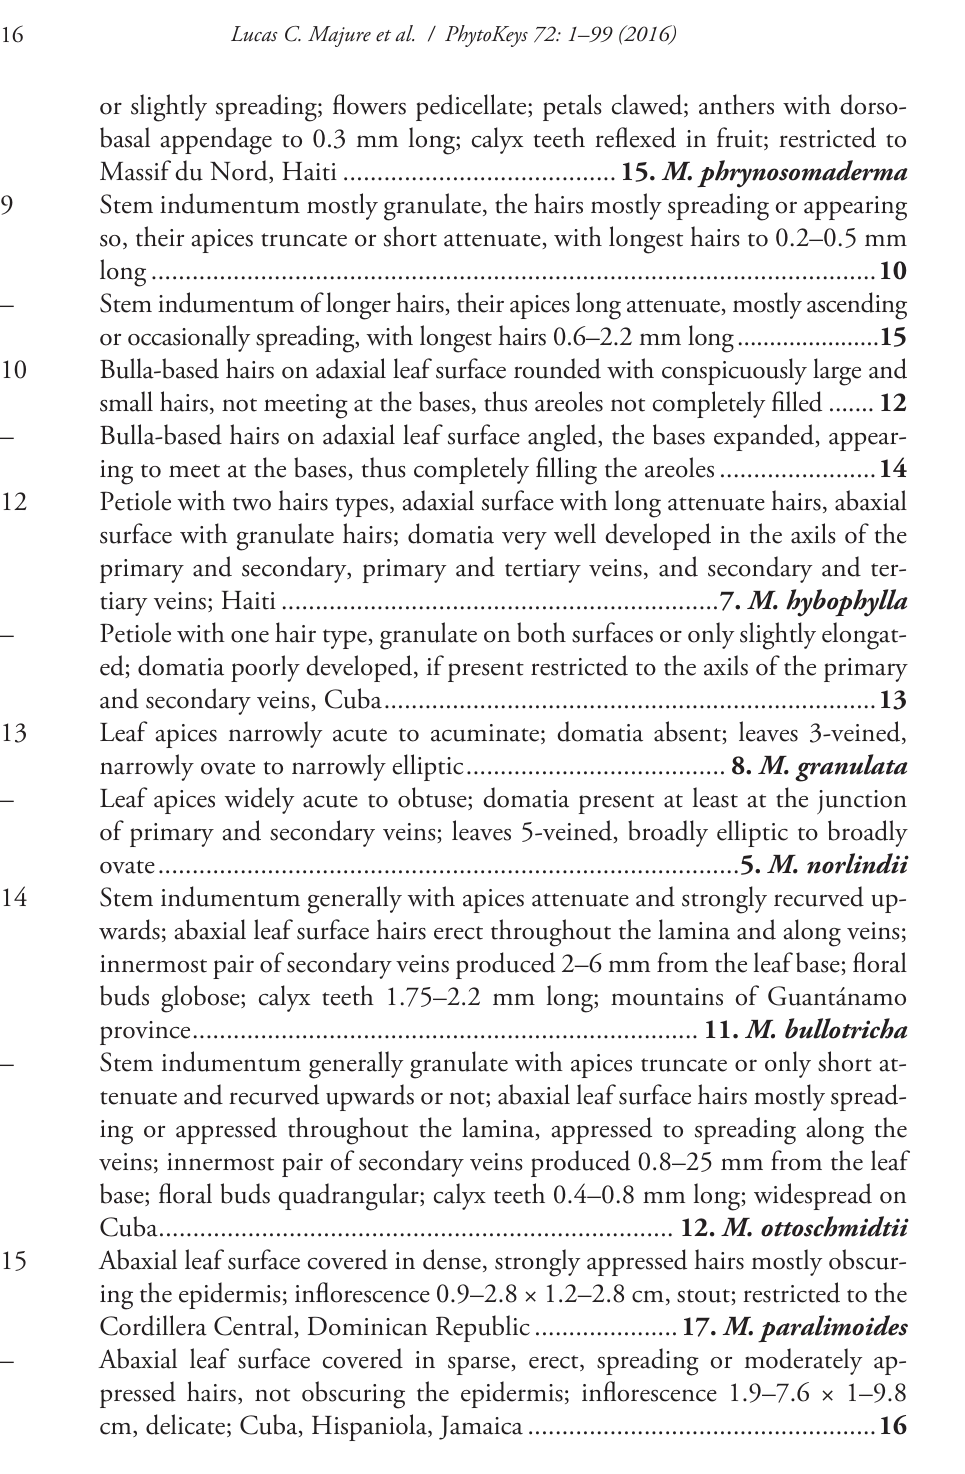
or slightly spreading; flowers pedicellate; petals clawed; anthers with dorso- basal appendage to 0.3 mm long; calyx teeth reflexed in fruit; restricted to Stem indumentum mostly granulate, the hairs mostly spreading or appearing so, their apices truncate or short attenuate, with longest hairs to 0.2–0.5 mm – Stem indumentum of longer hairs, their apices long attenuate, mostly ascending or occasionally spreading, with longest hairs 0.6–2.2 mm long ...................... 15 10 Bulla-based hairs on adaxial leaf surface rounded with conspicuously large and small hairs, not meeting at the bases, thus areoles not completely filled ....... 12 – Bulla-based hairs on adaxial leaf surface angled, the bases expanded, appear- ing to meet at the bases, thus completely filling the areoles ....................... 14 12 Petiole with two hairs types, adaxial surface with long attenuate hairs, abaxial surface with granulate hairs; domatia very well developed in the axils of the primary and secondary, primary and tertiary veins, and secondary and ter- – Petiole with one hair type, granulate on both surfaces or only slightly elongat- ed; domatia poorly developed, if present restricted to the axils of the primary 13 Leaf apices narrowly acute to acuminate; domatia absent; leaves 3-veined, – Leaf apices widely acute to obtuse; domatia present at least at the junction of primary and secondary veins; leaves 5-veined, broadly elliptic to broadly 14 Stem indumentum generally with apices attenuate and strongly recurved up- wards; abaxial leaf surface hairs erect throughout the lamina and along veins; innermost pair of secondary veins produced 2–6 mm from the leaf base; floral buds globose; calyx teeth 1.75–2.2 mm long; mountains of Guantánamo – Stem indumentum generally granulate with apices truncate or only short at- tenuate and recurved upwards or not; abaxial leaf surface hairs mostly spread- ing or appressed throughout the lamina, appressed to spreading along the veins; innermost pair of secondary veins produced 0.8–25 mm from the leaf base; floral buds quadrangular; calyx teeth 0.4–0.8 mm long; widespread on 15 Abaxial leaf surface covered in dense, strongly appressed hairs mostly obscur- ing the epidermis; inflorescence 0.9–2.8 × 1.2–2.8 cm, stout; restricted to the – Abaxial leaf surface covered in sparse, erect, spreading or moderately ap- pressed hairs, not obscuring the epidermis; inflorescence 1.9–7.6 ×